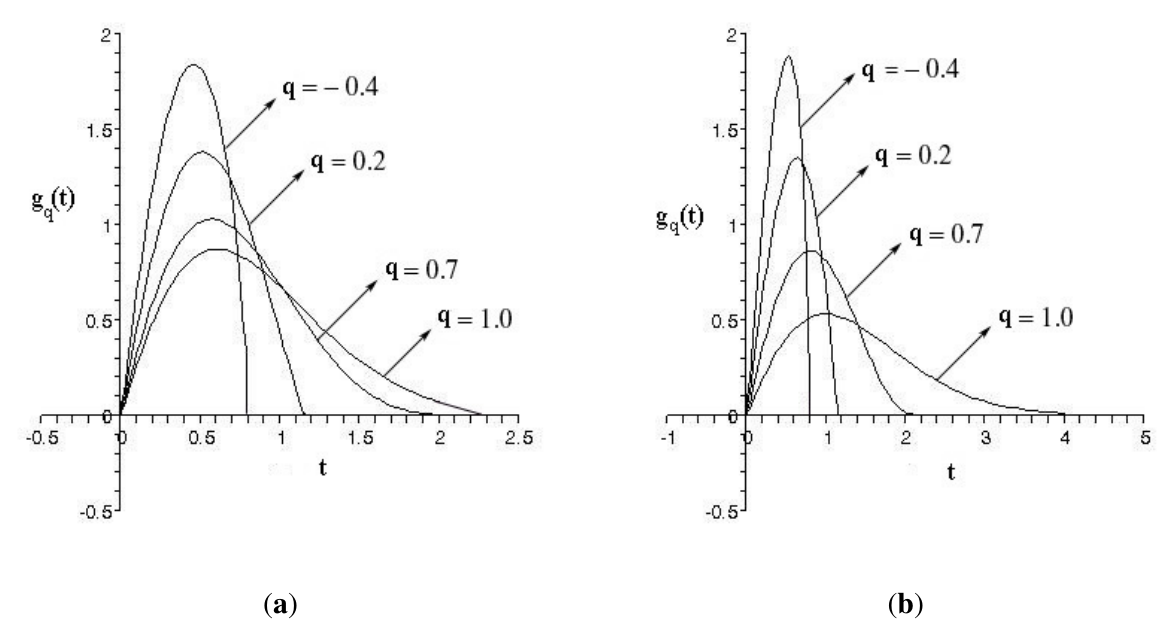
Figure 2. ( a ) The q -gamma Bessel model for q < 1 , δ = − 0 . 50 ; ( b ) The q -gamma Bessel model for q < 1 , δ = 0 . 5 .